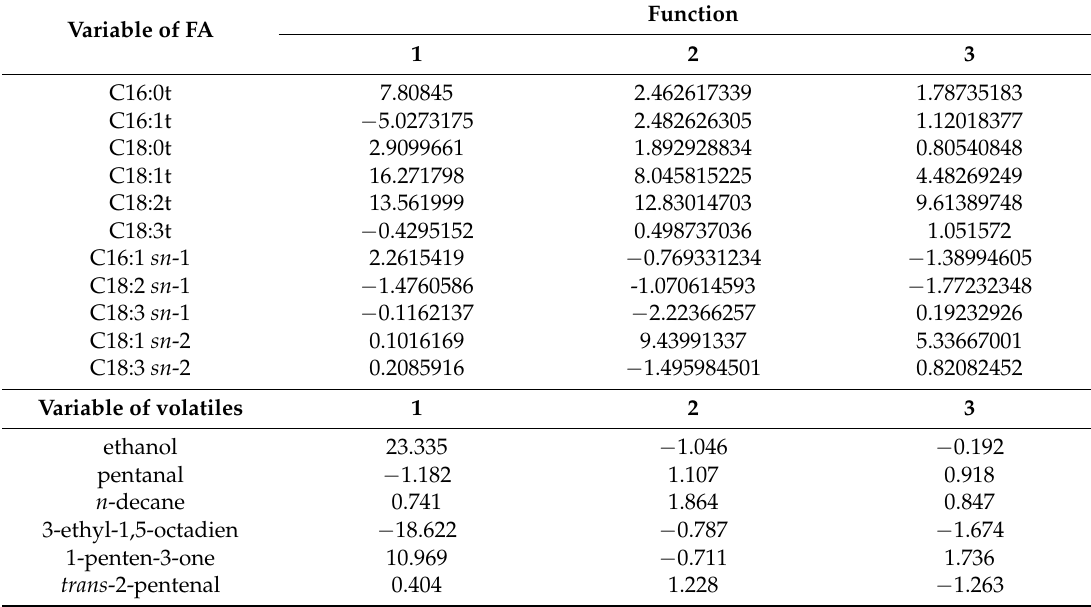
Table 5. Standardized canonical discriminant function coefficients obtained from LDA analysis using total and positional TAG acidic compositions of monovarietal EVOO samples.